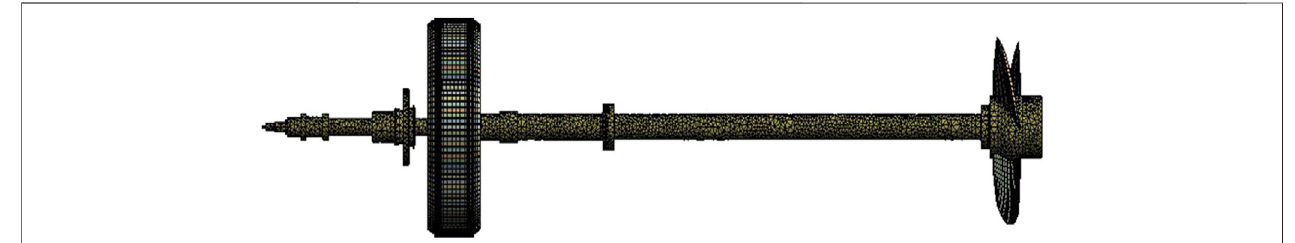
FIGURE 4 | Mesh of rotor